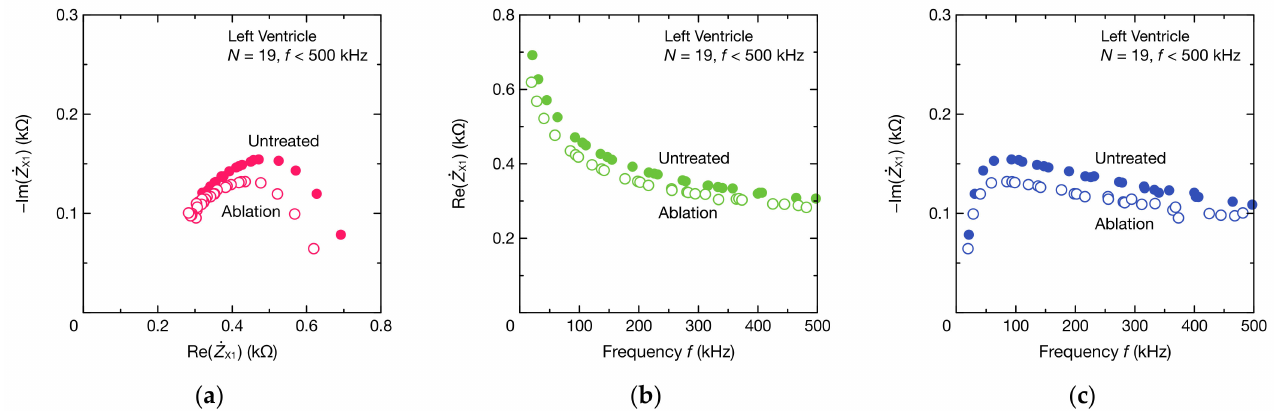
. Z X1 of the porcine myocardium: ( a ) the Cole–Cole plot, ( b ) the real part (cid:16) . (cid:17) . Z X1 represents the impedance obtained by subtracting the impedance of Z X1 . (cid:16) . (cid:17) (cid:17) (cid:16) . . Z X . Re Z X1 Z X in Figure 14. equals Re